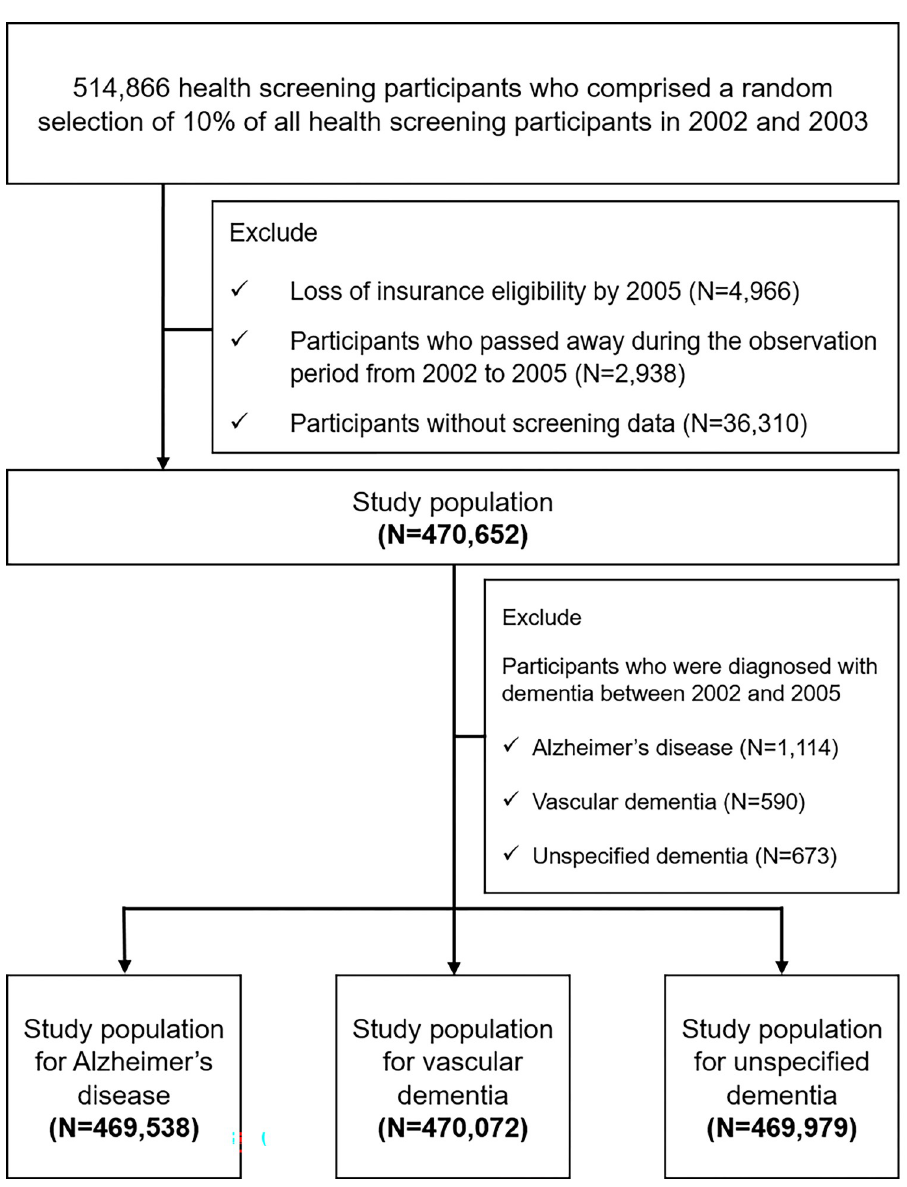
Fig 1. Flowchart for study population